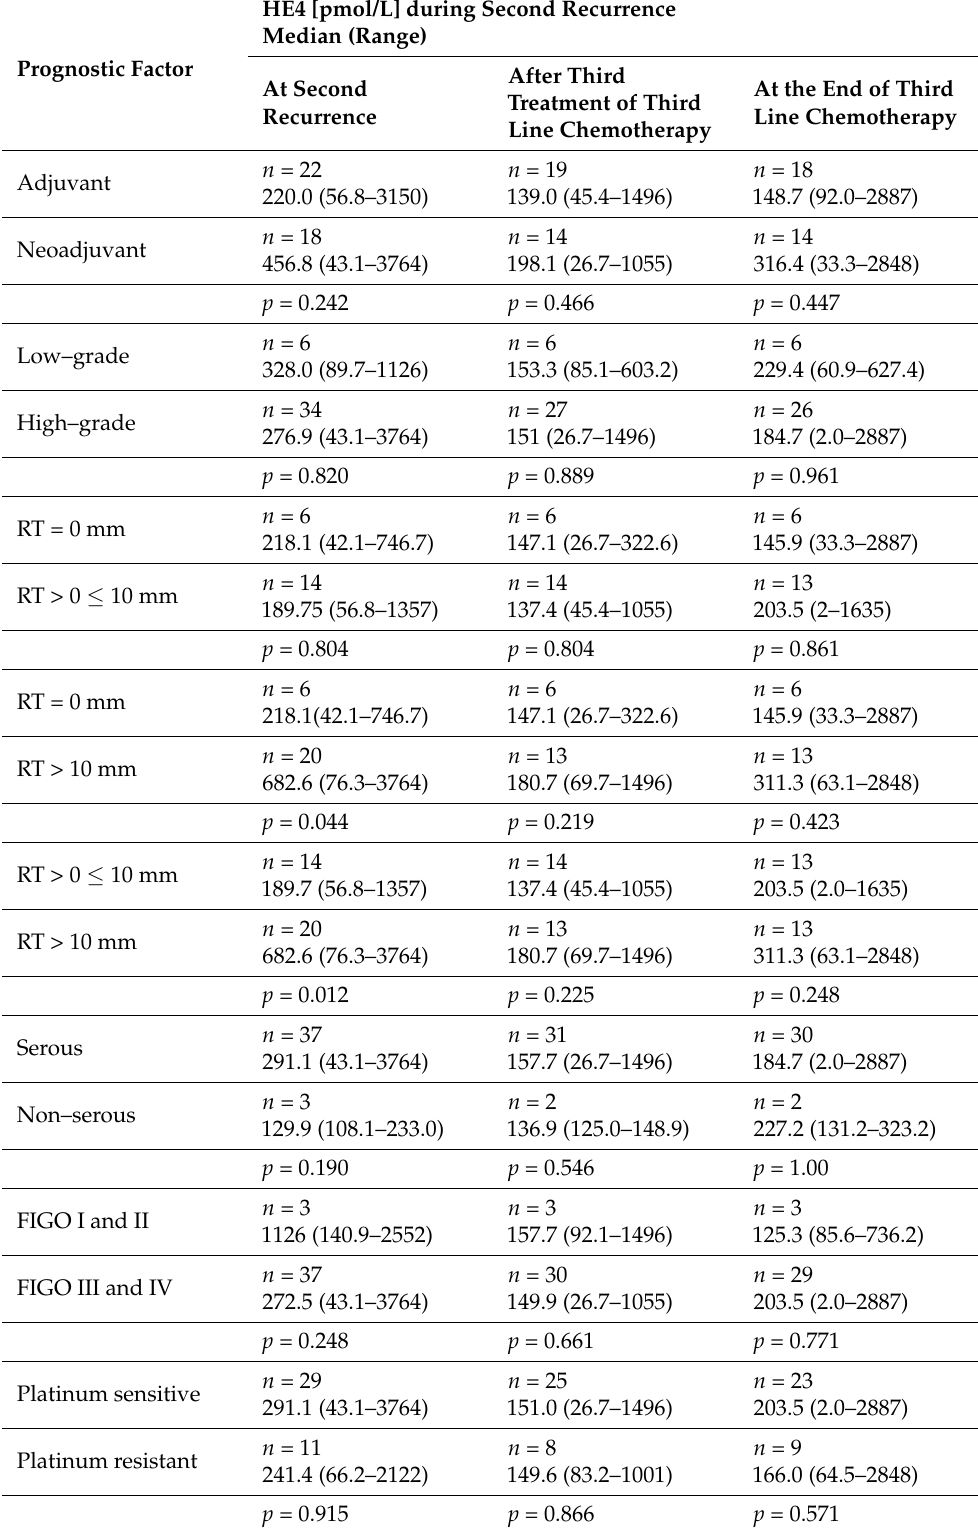
Table 4. HE4 serum concentration during the Second OC